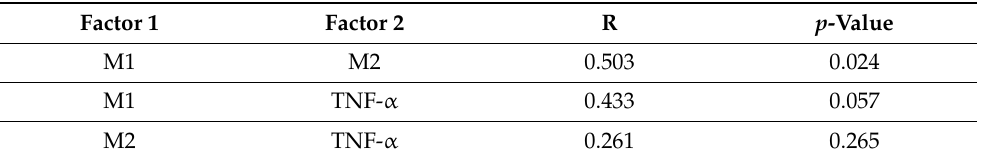
Table 4. The correlations between the factors in patients’ tissue samples based on the Spearman’s correlation